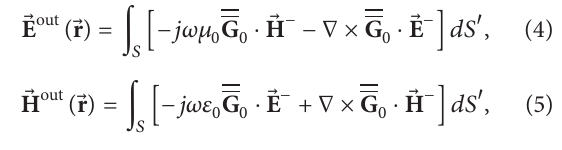
Figure 2: Incident fields on block- 𝑚 from the external excitation, the PO region, and all the other GTM